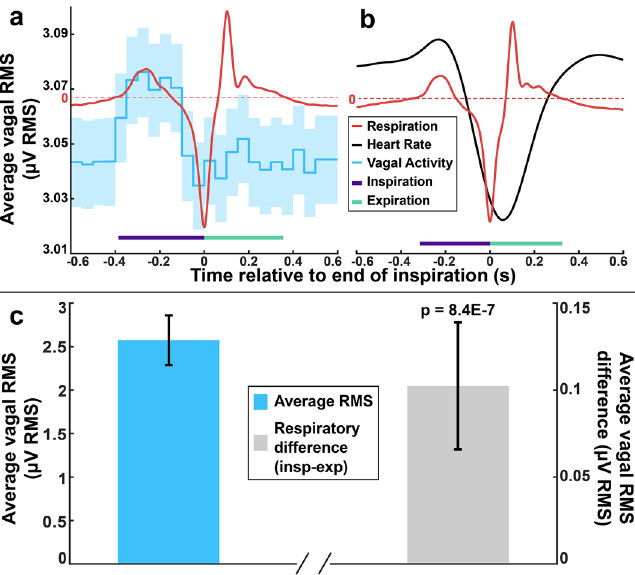
Figure 3. Average vagal activity measured during respiration, under anesthesia. ( a ) Sample dataset obtained from a 10-min recording showing the average accelerometer trace (red, used to measure inspiration and expiration phases), as well as average vagal RMS (blue, with shaded area representing the 95% confidence interval). ( b ) Sample dataset obtained from another 10-min recording showing the average accelerometer trace as well as the average heart rate (black). ( c ) Average values for the total anesthetized RMS (left) and the RMS difference between inspiration and expiration phases (right) using accelerometer to signal respiration (61 recordings total from 4 animals). The respiratory difference is 0.10 ± 0.15 µV RMS, which is significantly different from zero ( p =